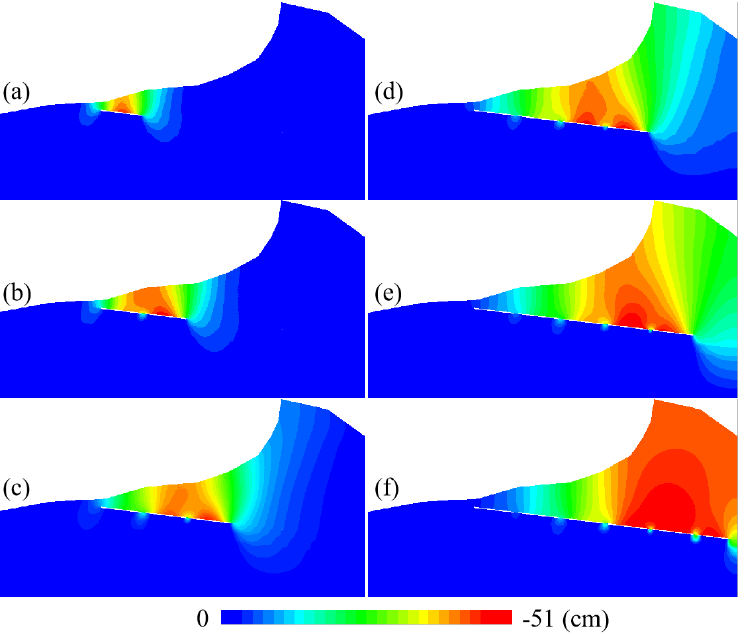
Figure 11. Variation of vertical displacement: ( a ) simulation of displacement change after the 1st mining; ( b ) simulation of displacement change after the 2nd mining; ( c ) simulation of displacement change after the 3rd mining; ( d ) simulation of displacement change after the 4th mining; ( e ) simu- lation of displacement change after the 5th mining; ( f ) simulation of displacement change after the 6th